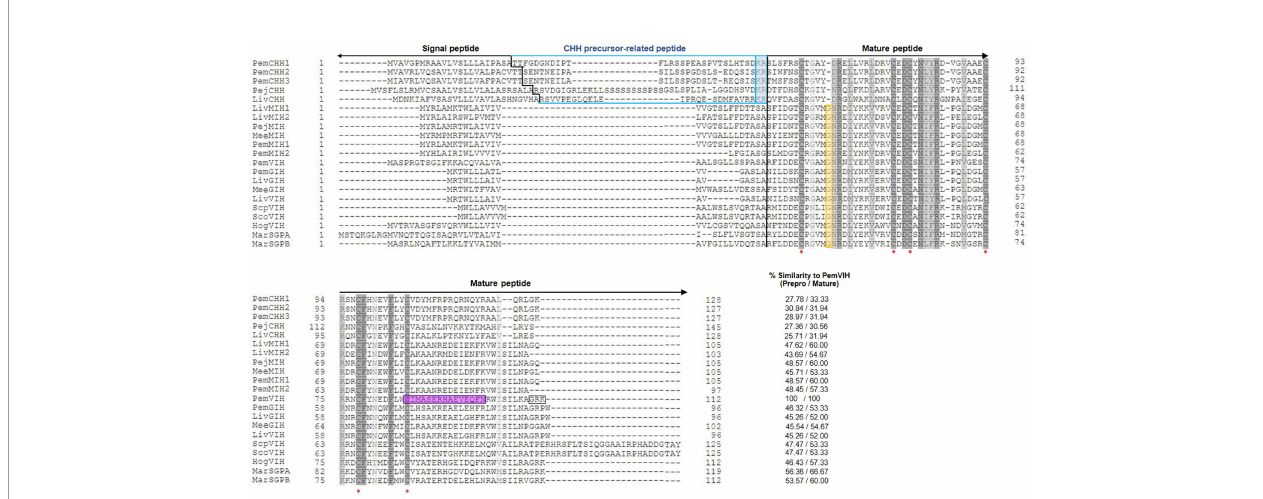
FIGURE 1 | Multiple amino acid sequence alignment of CHH superfamily in crustaceans. It includes PemVIH, PemCHH1, PemCHH2, PemCHH3, PejCHH, LivCHH, LivMIH1, LivMIH2, PejMIH, MeeMIH, PemMIH1, PemMIH2, PemGIH, LivGIH, LivVIH, MeeGIH, ScpVIH, ScoVIH, HogVIH, MarSGPA, and MarSGPB (see species of origin and accession numbers in Table 2 ). Amino acid numbering is indicated in margins of the sequences. Percent similarity to the prepro- and mature PemVIH is shown in the bottom right column. Identical and similar amino acid residues are shaded in dark gray and light gray, respectively. Red asterisks indicate six conserved cysteine residues. A black vertical line indicates the predicted signal peptide cleavage sites. A blue line covers CPRP of CHH-type I and blue highlight shows dibasic residue (KR) of CHH-type I. The conserved glycine residues of CHH-type II are highlighted in yellow. The peptide sequence that was selected for antibody production against PemVIH is highlighted in purple. Boxed area indicates the predicted dibasic cleavage site of PemVIH at “ RK ” and amidation site at “ G ”